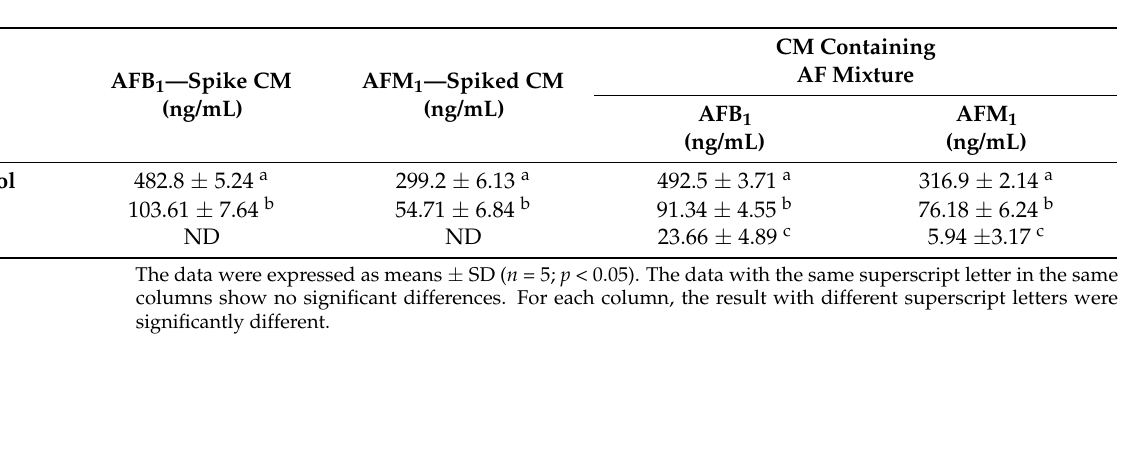
Table 7. Aflatoxin reduction using spiked camel milk fermented using bacterial strains of NRC 06 and NRC